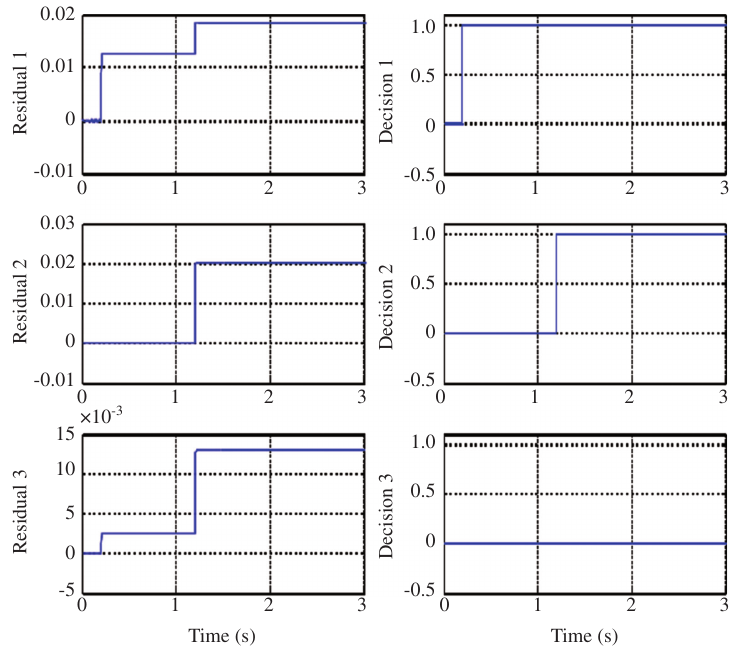
Figure 6. Residuals with a Non-additive Fault on Joint 1 at t = 0.2 s and Joint 2 at t = 1.2 s.